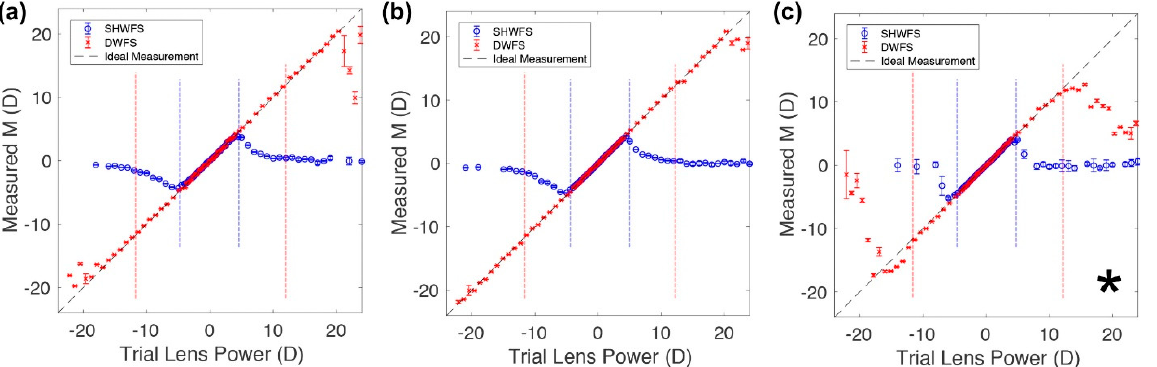
Figure 8. The measured spherical equivalent power (M) versus the trial lens power for SHWFS (blue symbols) and DWFS (red symbols) for three different illuminating sources: LD ( a ), LD+LSR ( b ), and LED ( c ). Dashed vertical lines indicate the corresponding predicted dynamic range. * Power-limited. Figure reused from Ref. [24] under the terms of the OSA Open Access Publishing Agreement, © 2019 Optical Society of America.